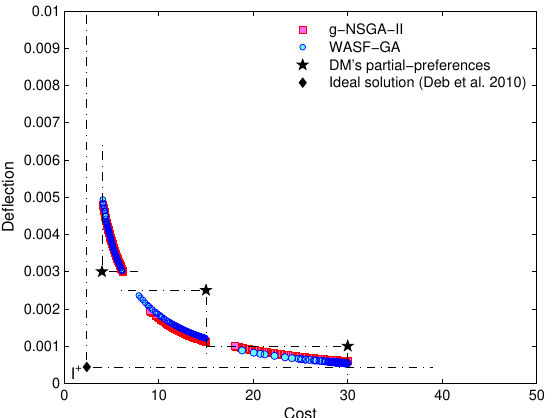
Figure 8. DM’s partial-preferences ( 4,0.003 ) , ( 15,0.0025 ) and ( 30,0.001 ) and the respective approximate POF with the hypervolume indicator closest to the average value of hypervolume after 100 runs for g-NSGA-II and WASF-GA ( N = 100).